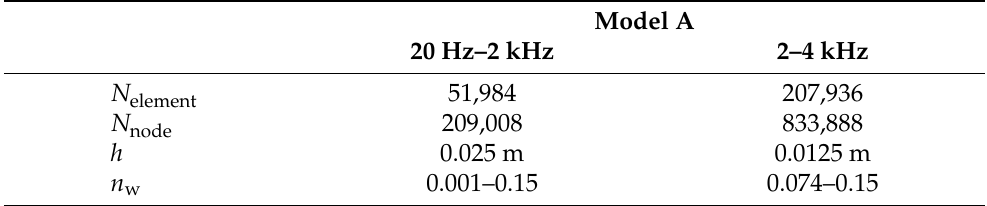
Table 3. Detailed information of the used meshes for the quadratic FE